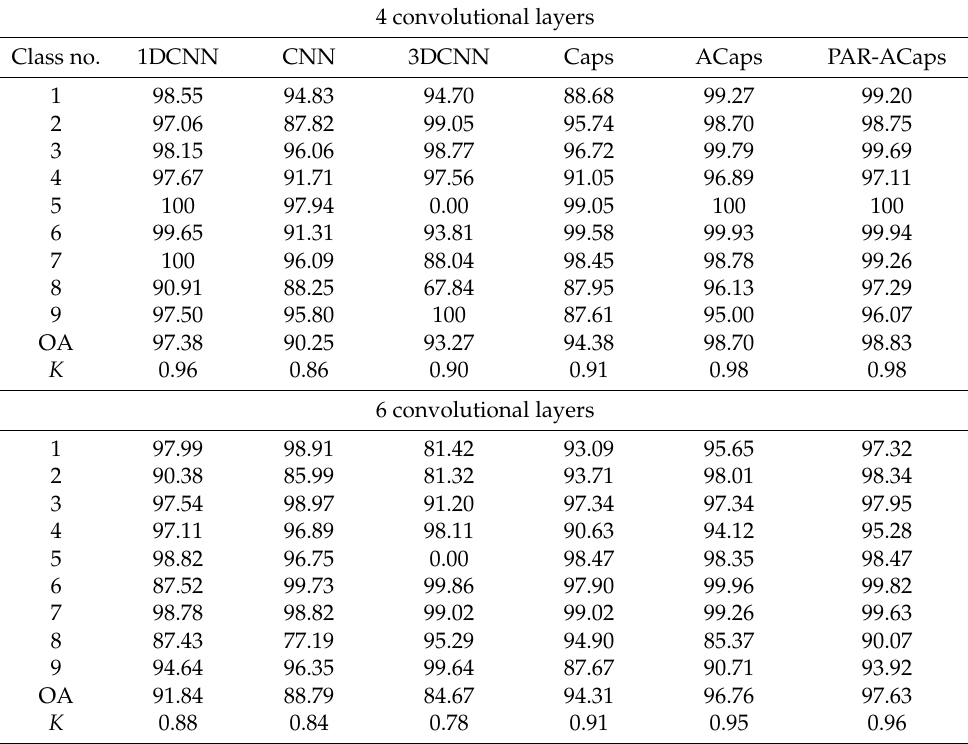
Table 6. The overall accuracy (%), per-class accuracy (%), and the Kappa coefficients ( K ) of PU dataset derived from CNN, Caps, ACaps, and PAR-ACaps with relatively deeper architectures. 4 convolutional layers Class no.